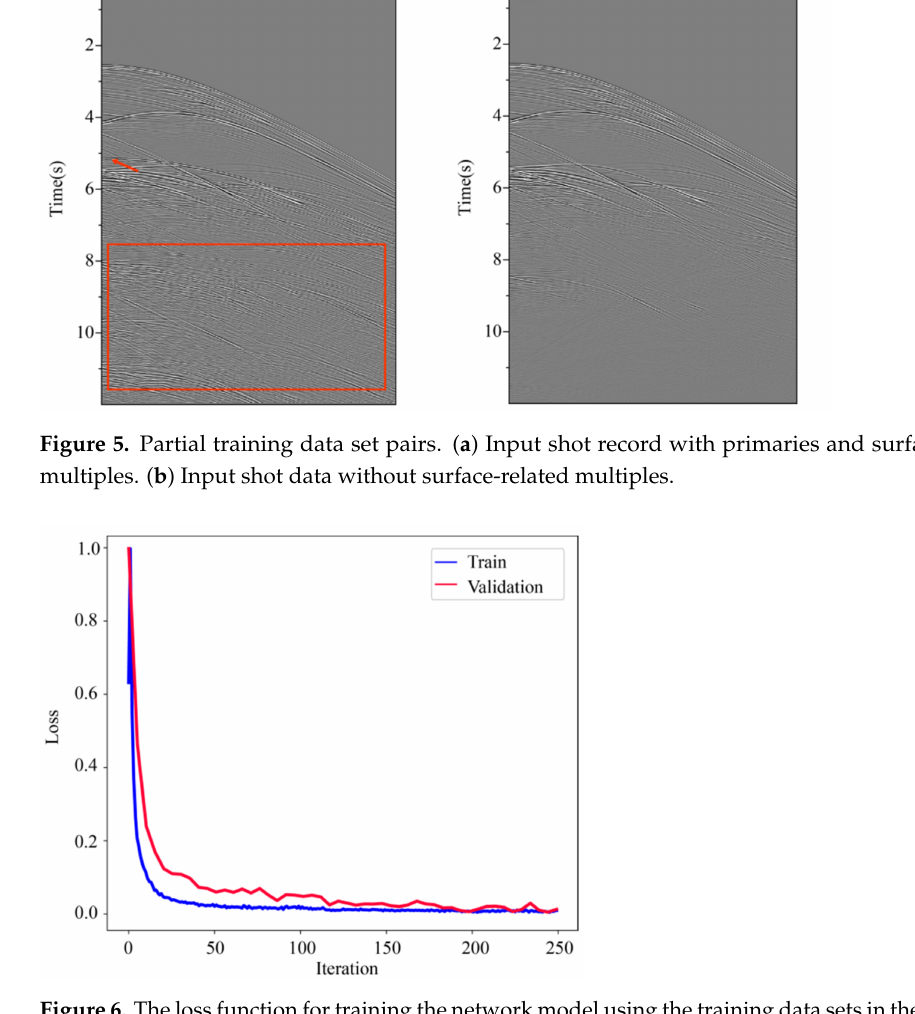
Figure 6. The loss function for training the network model using the training data sets in the Sigsbee2B model data.